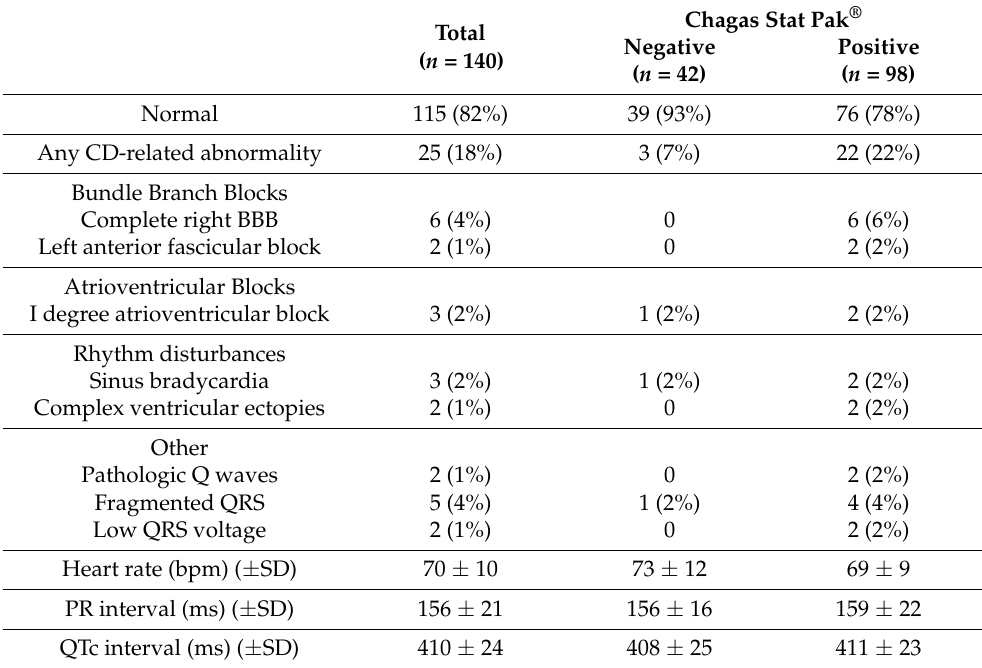
Table 2. Electrocardiographic findings in T. cruzi infected and uninfected population of a rural community of the Bolivian Chaco. Chagas Stat Pak ® Total Negative Positive ( n = 140) ( n = 42) ( n = 98) Normal 115 (82%) 39 (93%) 76 (78%) Any CD-related abnormality 25 (18%) 3 (7%) Bundle Branch